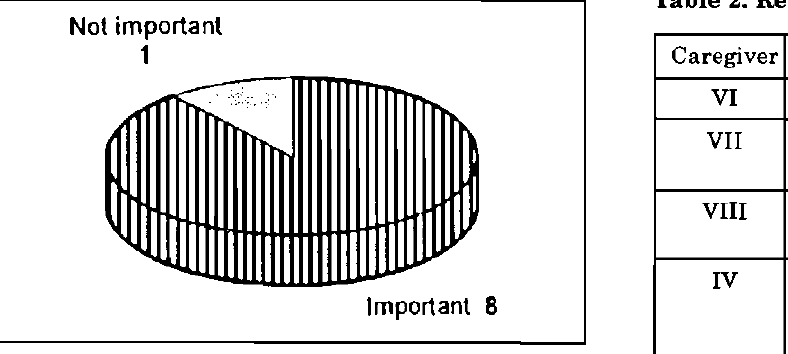
Table 2. Reasons for not playing with children